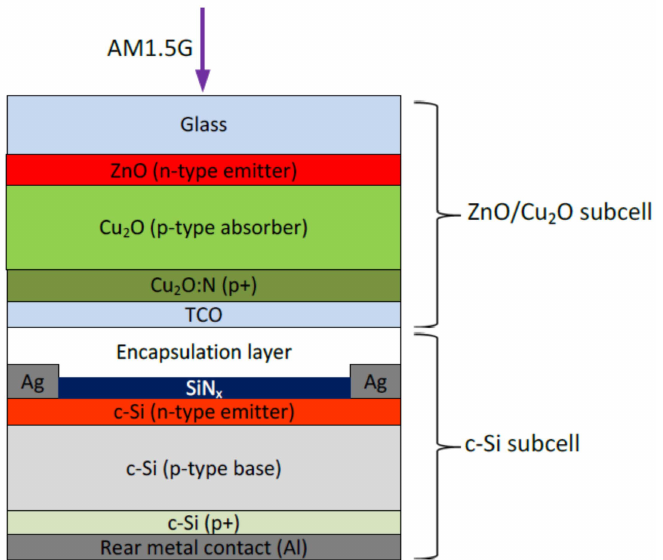
Figure 3. Schematic device design of a four-terminal tandem heterojunction solar cell combining a conventional crystalline Si as bottom sub-cell with a metal oxide top sub-cell based on ZnO and Cu 2 O layers